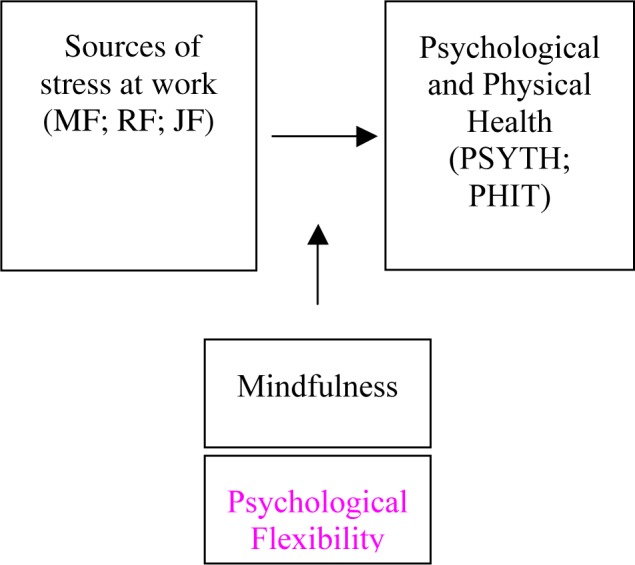
Conceptual model.